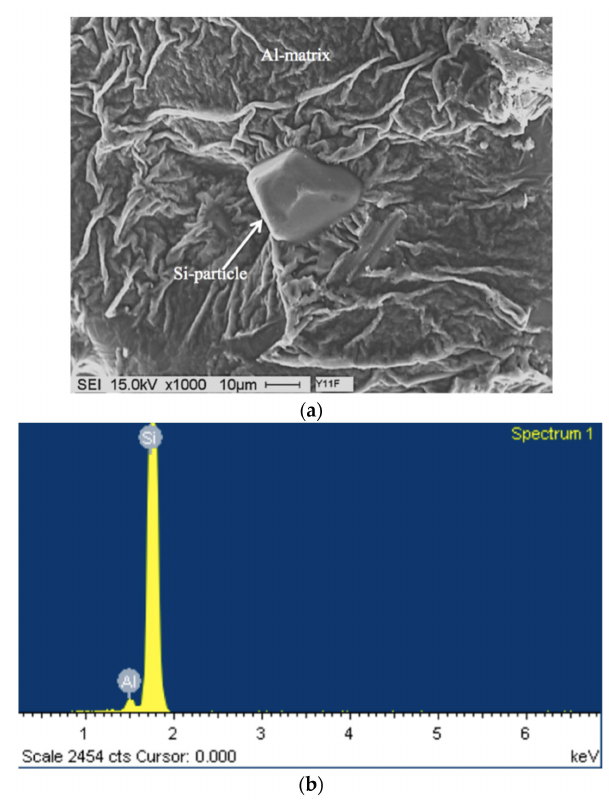
Figure 11. ( a ) Secondary electron image of the fracture surface of A1B alloy solutionized at 560 ˝ C for 12 h, DAS ~ 25 µ m; ( b ) EDS